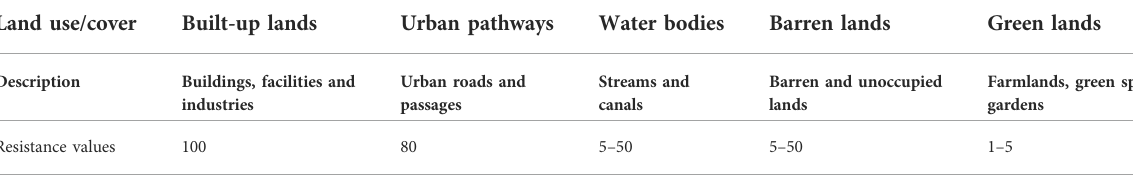
TABLE 1 The score of each land use resistance to modeling least-cost patches.